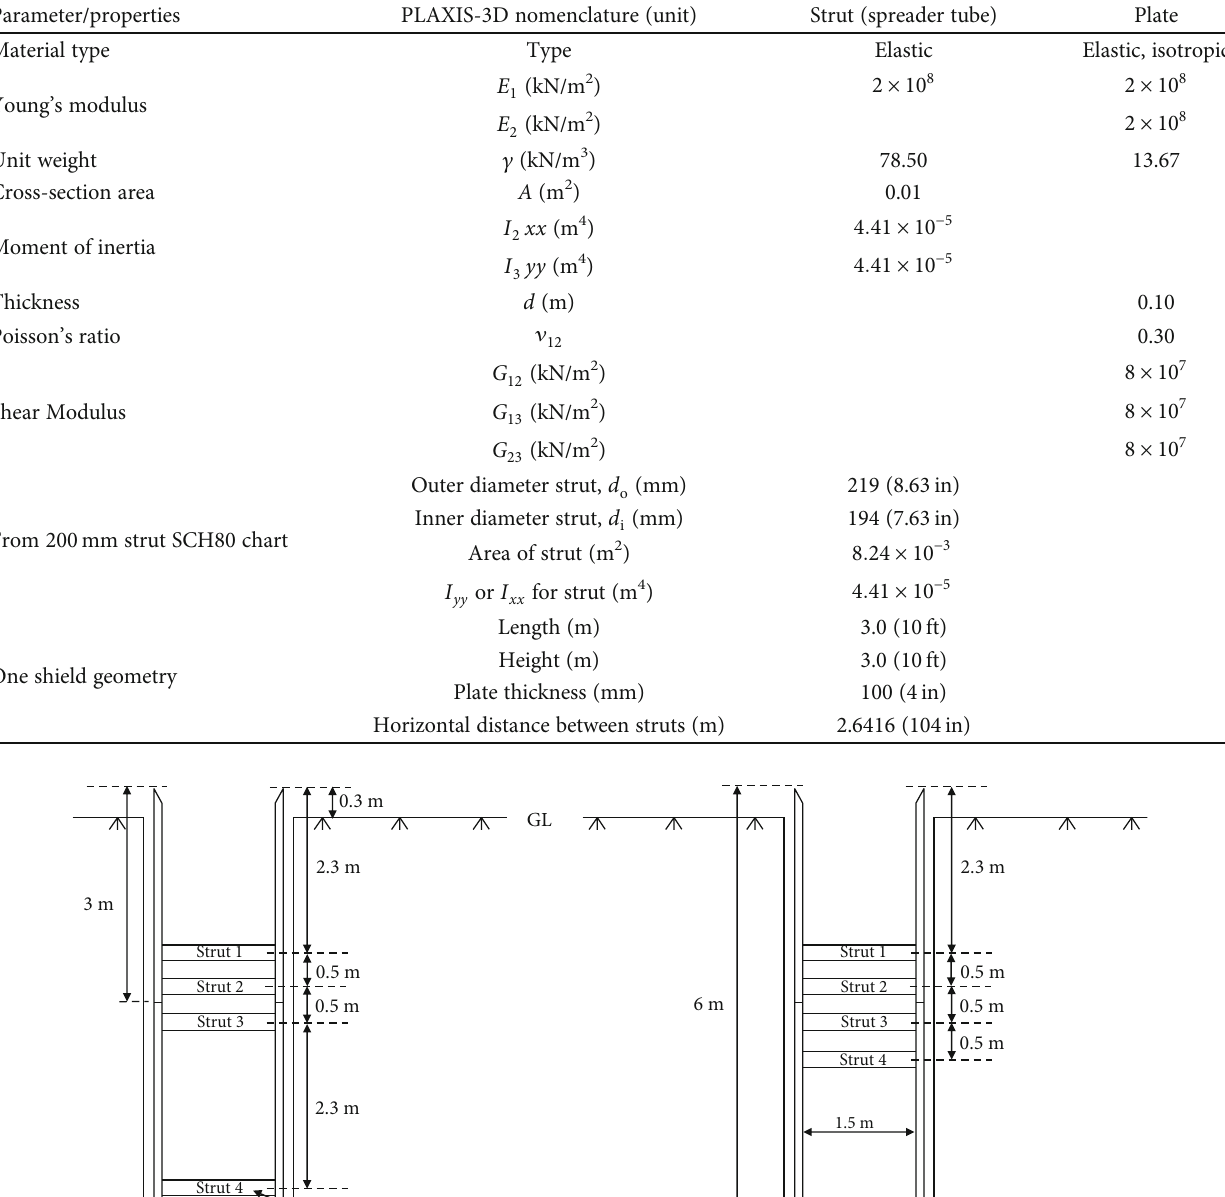
Table 1: Geometric and mechanical properties of box shield protection used for FE simulation in